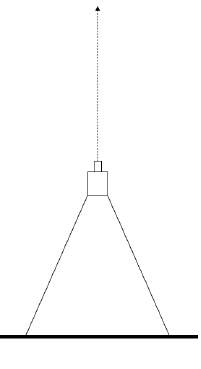
Figure 3. Illustration of zenith facing camera for static image testing using Earth rotation. Angular movement of stars through camera field of view caused solely by Earth